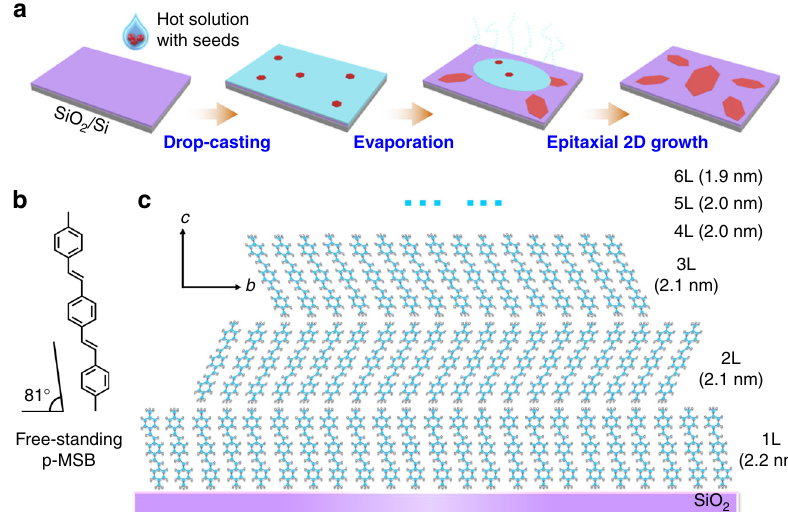
Fig. 1 Growth of two-dimensional (2D) p-MSB crystals. a Schematic illustration of the drop-casting growth process. b A freestanding p-MSB molecule. c Schematic illustration of the molecular packing of 1 L, 2 L, and 3 L on SiO 2 /Si within the b – c